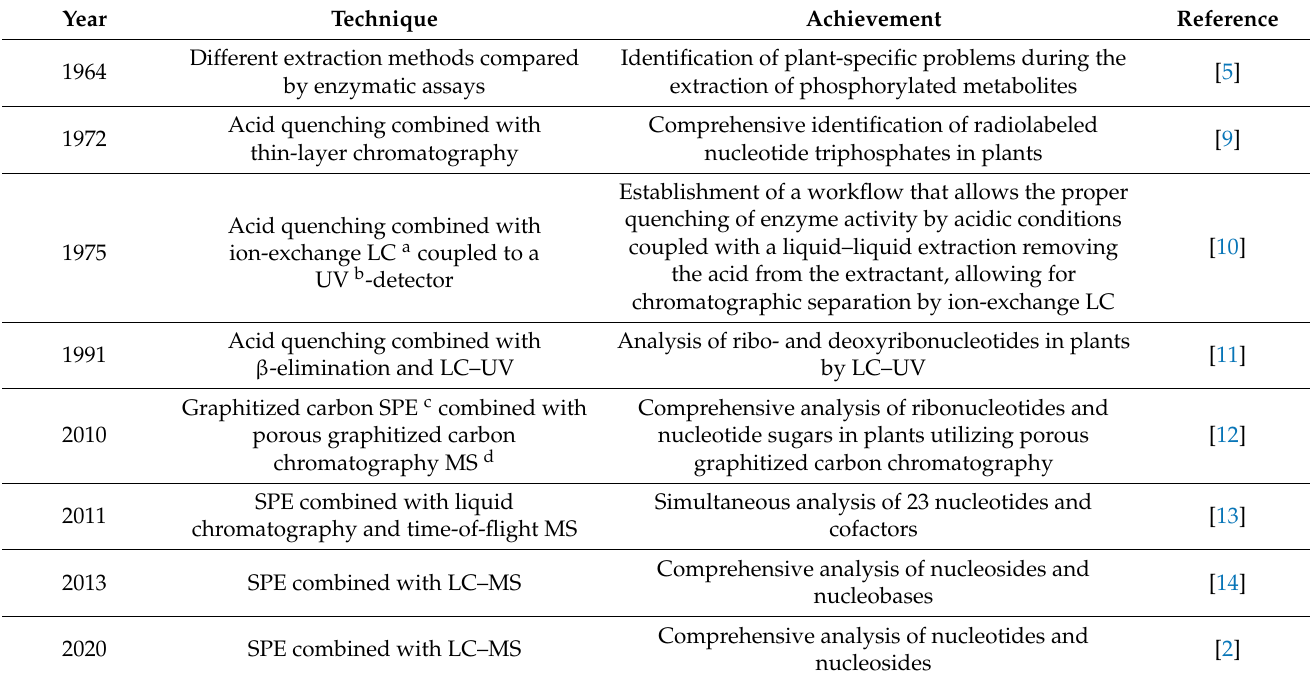
Table 1. Milestones in the development of a workflow for the comprehensive analysis of nucleotides, nucleosides, and nucleobases in